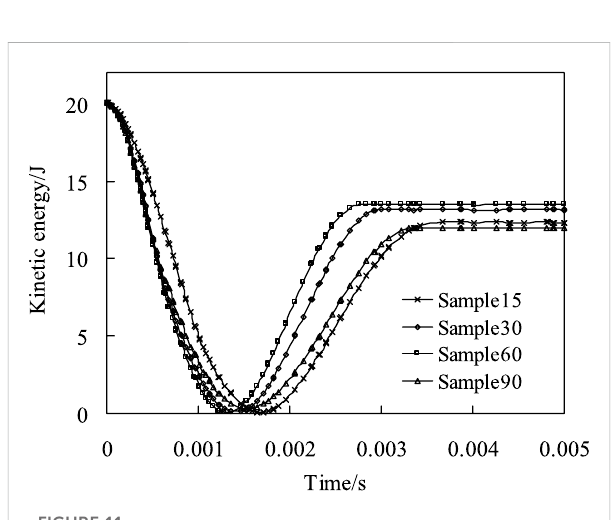
FIGURE 11 Thechangehistoryofkineticenergyofthefourmodelswhenthe impact energy is 20